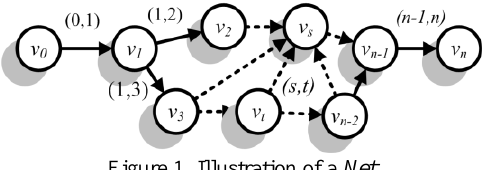
Figure 1. Illustration of a